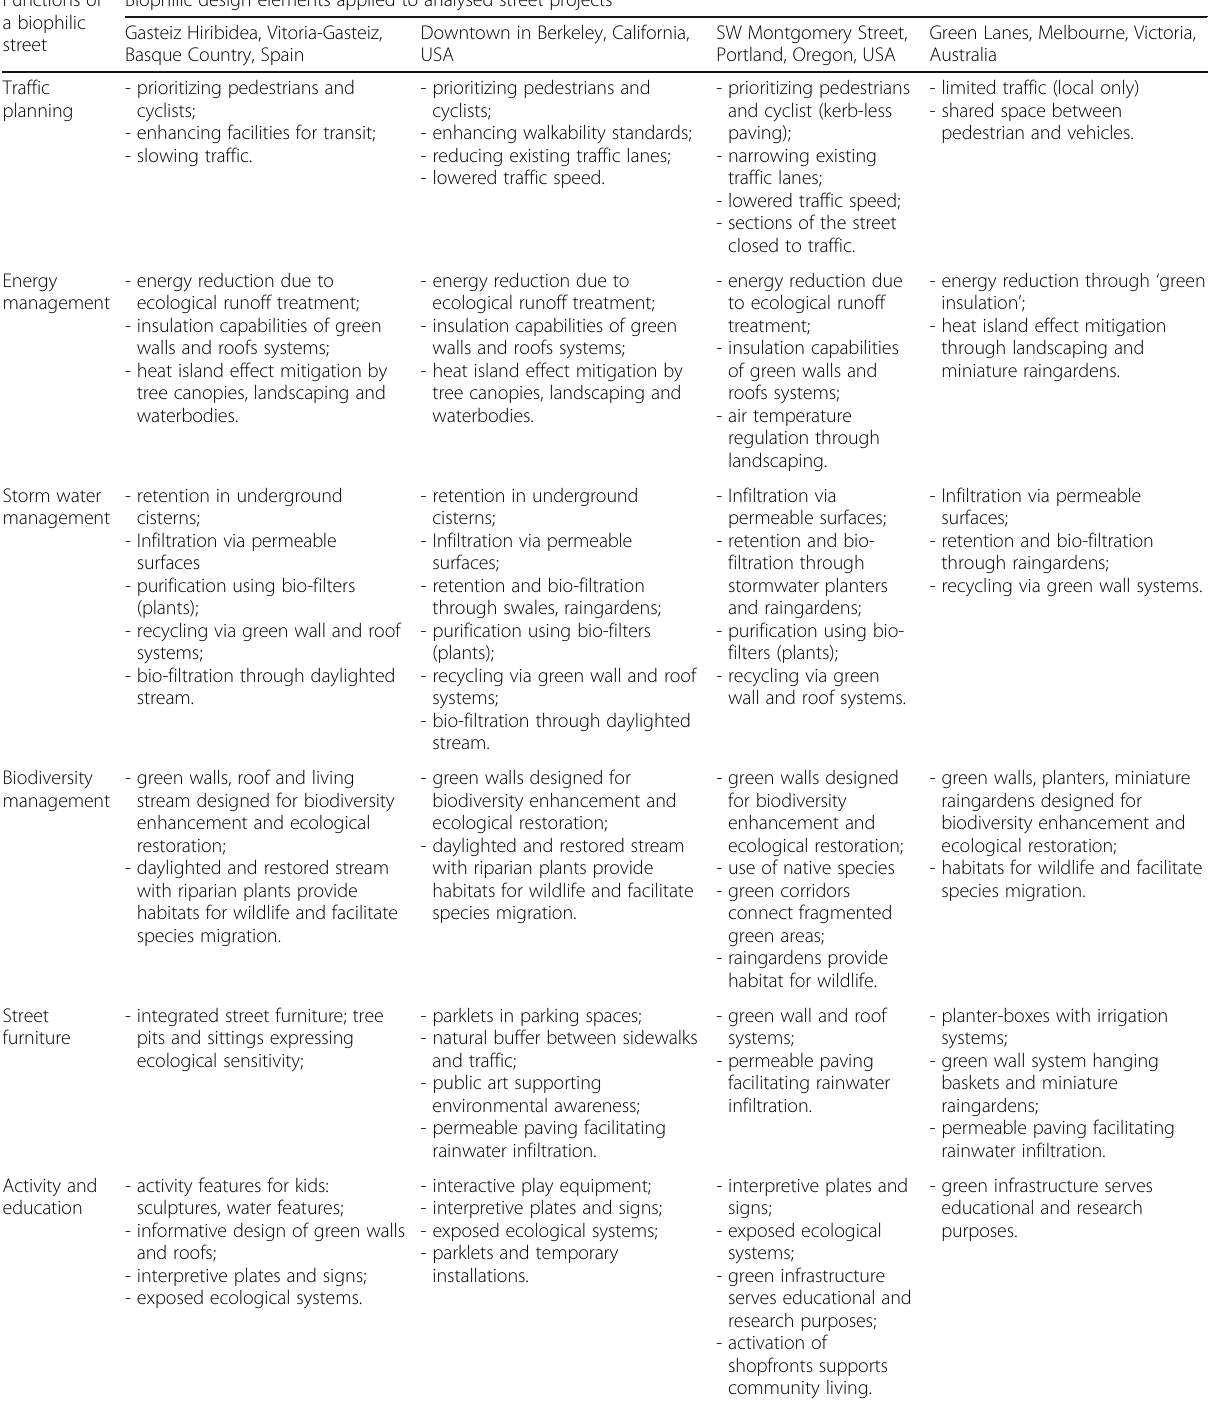
Table 5 Application of the framework for biophilic streets design in four analysed street projects Functions of a